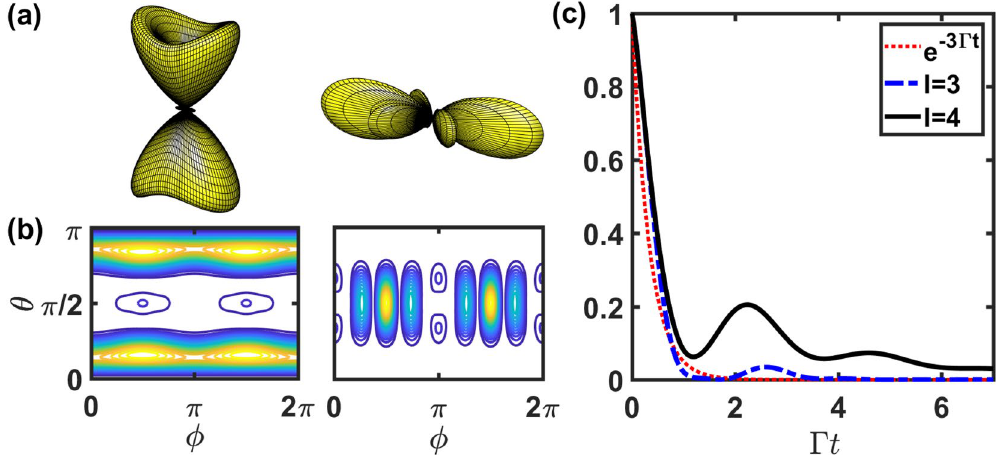
Figure 4. The far-field Ω f ( θ , φ ) of ˆ x -polarized HPI three-photon states for N = 8 on a ring. ( a ) Three- dimensional plots of Ω f ( θ , φ ) of subradiant states with l = 3 and 4. Corresponding two-dimensional plots are shown in ( b ). ( c ) The fluorescence intensity I 0 (t) of the HPI three-photon states with l = 3 and 4, compares with e − 3 Γ t . The viewing angle and other parameters are the same as in Fig.